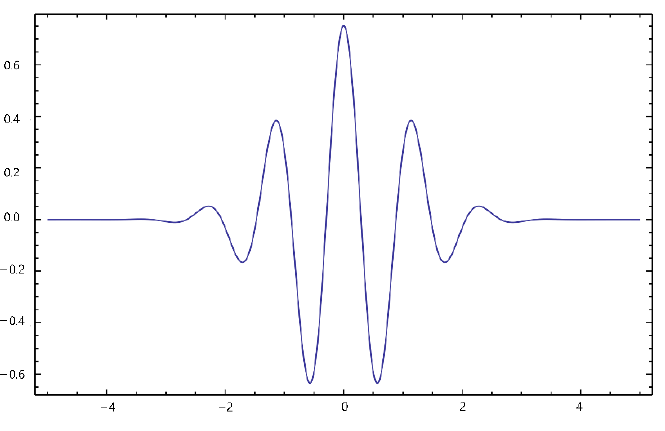
Figure 3. The process of brain connectivity analysis.